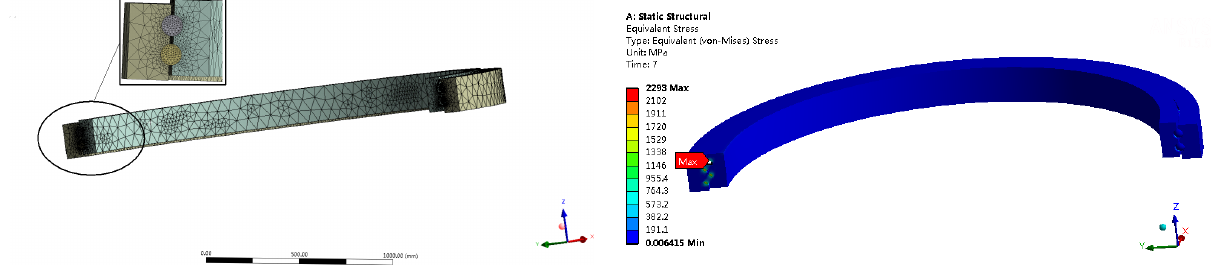
Figure 17: Equivalent stress distribution of slewing bearing